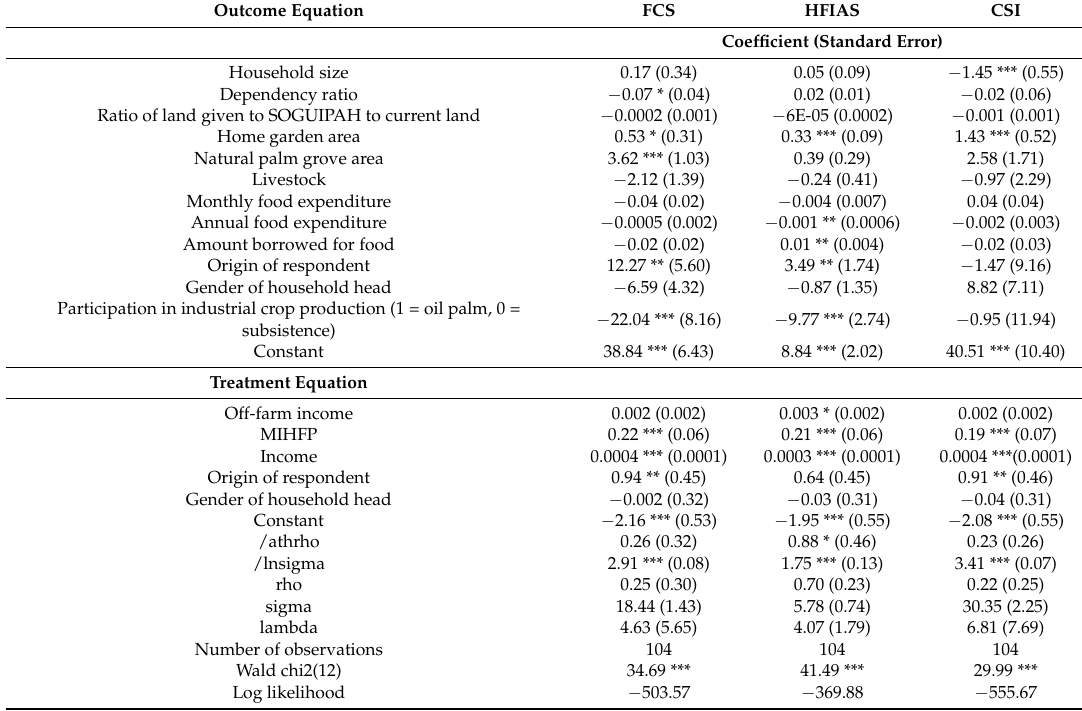
Table 6. Linear Regression with Endogenous Treatment Effects for participation in oil palm